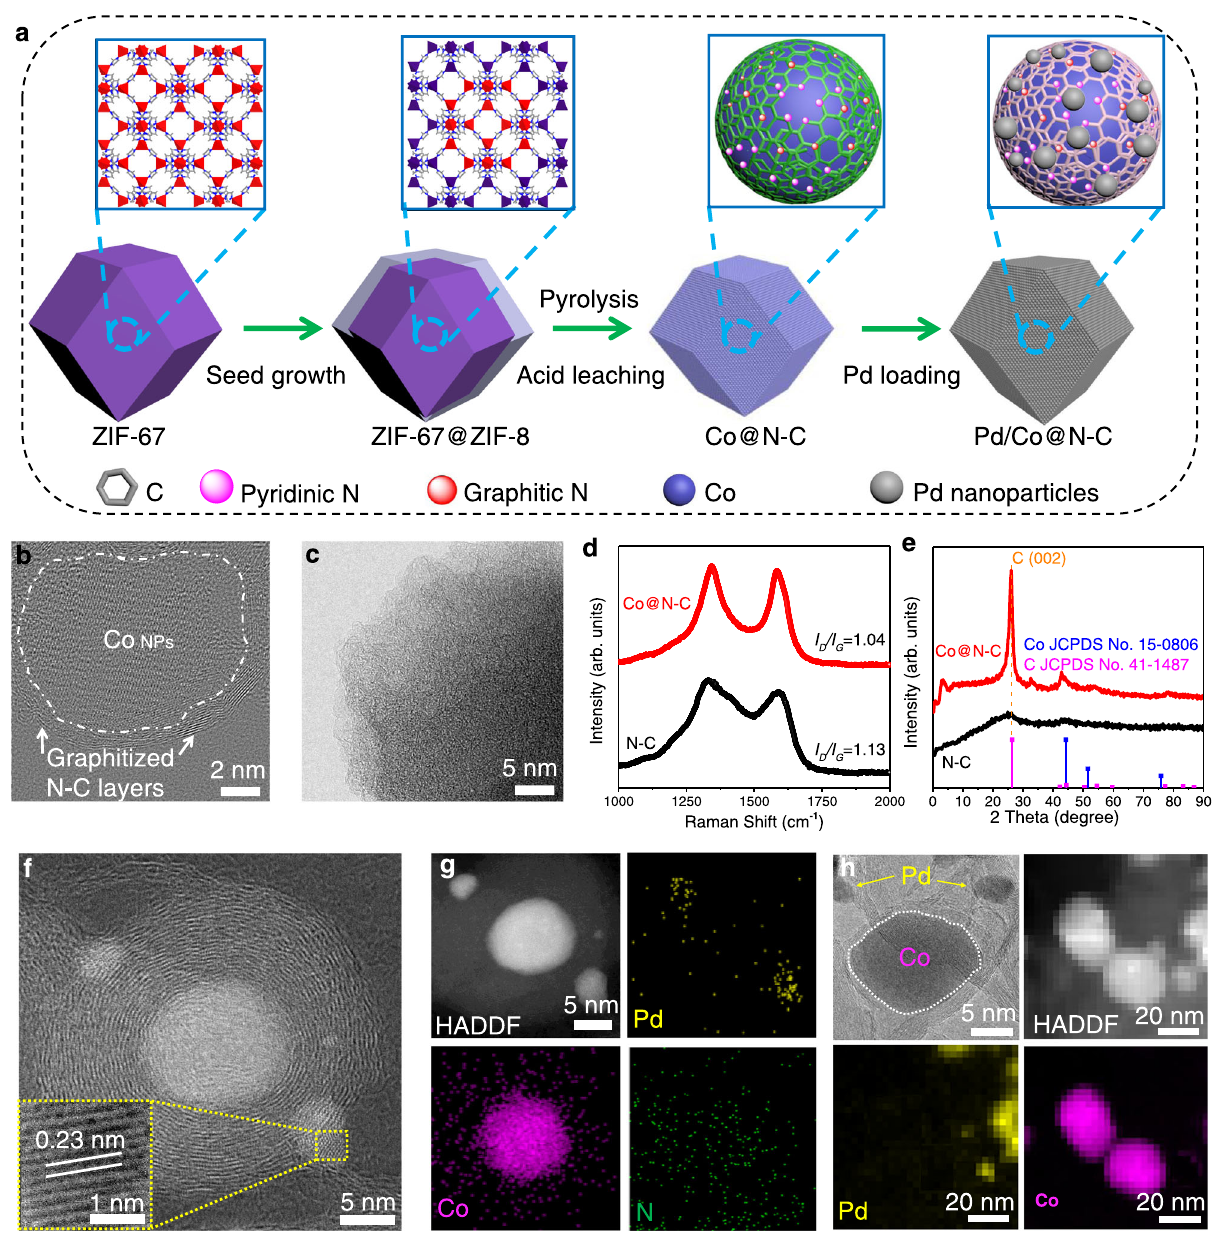
d Raman spectra and e XRD patterns of Co@N-C and N-C. f High-magni fi cation bright fi eld(BF)-STEMimage.Theinsetof( f )showstheenlargedSTEMimageofPd. g HAADF-STEM and the corresponding EDS elemental mappings of Pd, Co, and N. h HR-TEM, HAADF-STEM, and the corresponding EDS elemental mappings of Pd and Co of